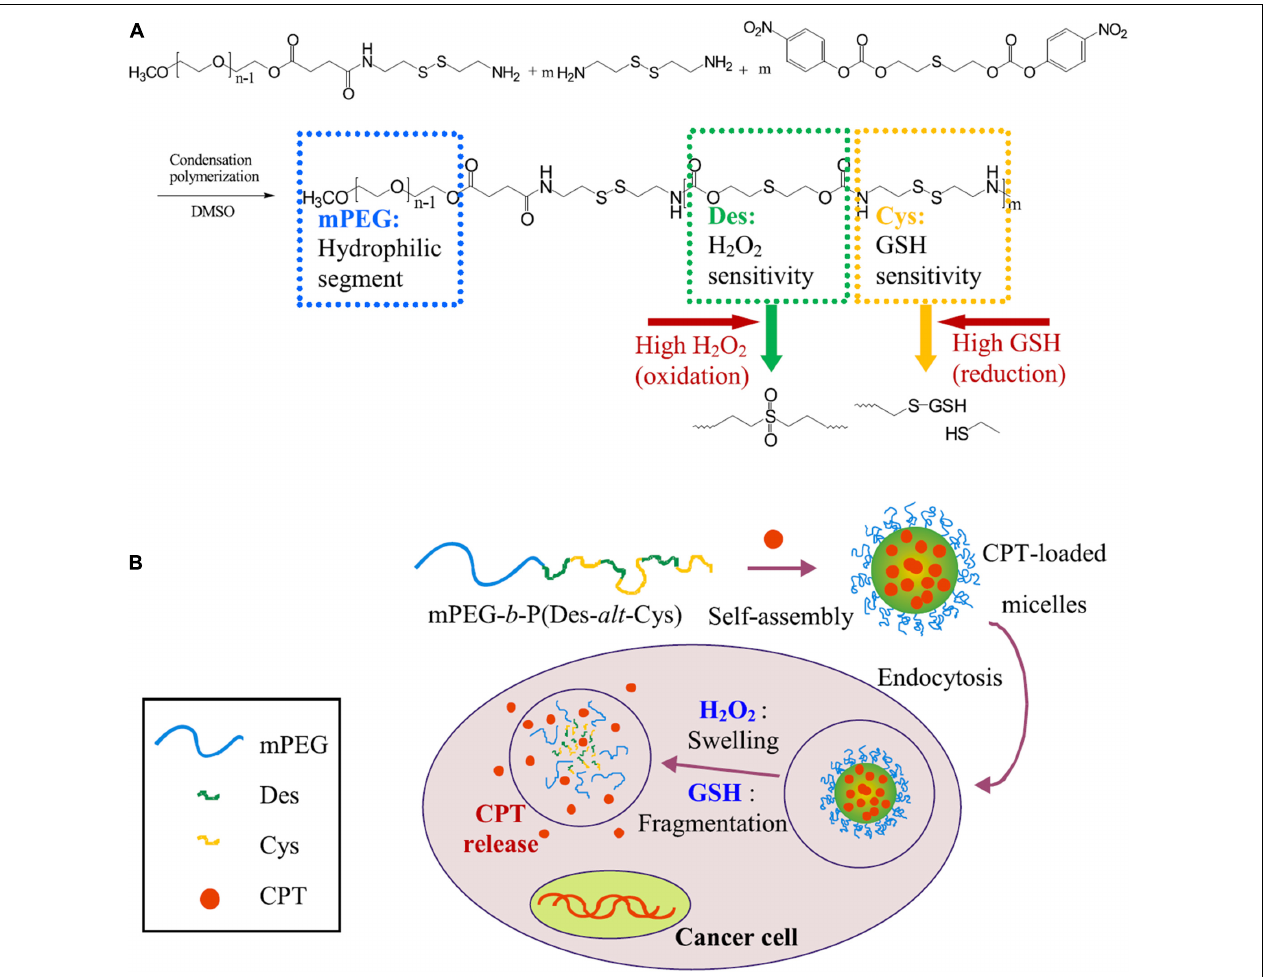
FIGURE 4 | Schematic illustration of dual redox-responsive micelles. (A) Chemical structure of mPEG-b-P(Des-alt-Cys) copolymer and (B) dual redox-responsive micelles and CPT release triggered by ROS and GSH. The dual redox-responsive micelles enter into cancer cells and exhibited high levels of ROS and GSH, then the structures of micelles are deformed, and the encapsulated CPT could be liberated from micelles, leading to selectively location-controlled drug release. Reprinted from Yi-Ting Chiang, Yu-Wei Yen, and Chun-Liang Lo. Reactive oxygen species and glutathione dual redox-responsive micelles for selective cytotoxicity of